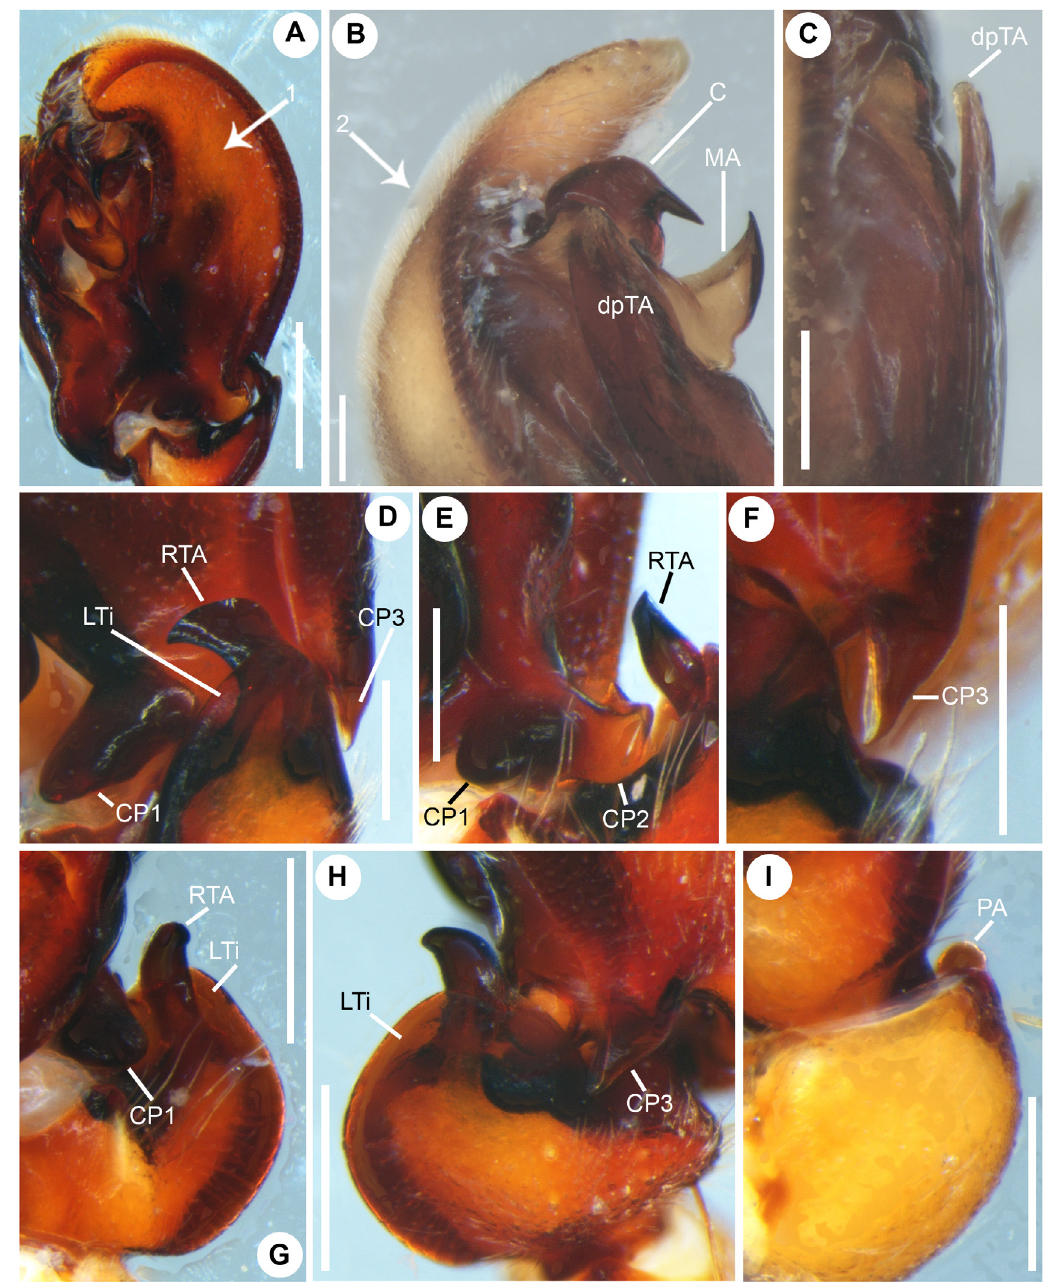
Fig. 4. Laminion birenifer (Gravely, 1921) gen. et comb. nov., ♂, syntype of Storena birenifer Gravely, 1921 (NZC-ZSI-2914/H2), left pedipalp. A . Cymbial retrolateral flange, ventral view. B . Distal part of cymbium and bulb, prolateral view. C . Disto-prolateral tegular apophysis, dorso-prolateral view. D – I . Details of retrolateral tibial apophysis, cymbial processes, lamellate extension of tibia and patellar apophysis. D , F . Retrolateral view. E . Ventral view. G . Prolatero-ventral view. H . Dorso-ventral view. I . Ventral view. Abbreviations: C = conductor; CP1 = first cymbial process; CP2 = second cymbial process; CP3 = third cymbial process; dpTA = disto-prolateral tegular apophysis; LTi = lamellate extension of tibia; MA = median apophysis; PA = patellar apophysis; RTA = retrolateral tibial apophysis. Scale bars: A = 0.5 mm; B–I = 0.2 mm. Arrows: 1 indicates cymbial retrolateral flange, 2 indicates dorsal hair mat of